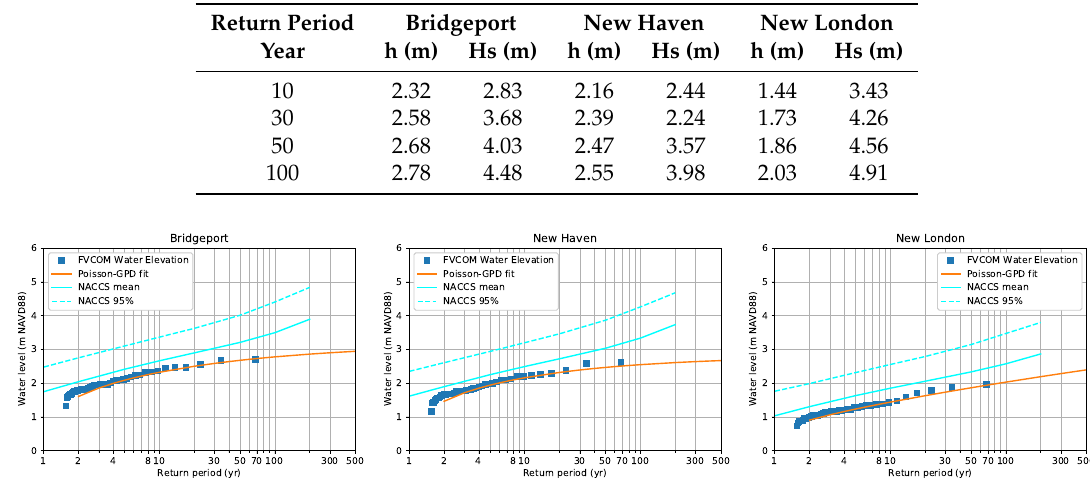
Figure 6. Estimated return level (colored contour) and return period (vertical axis) for water level ( a ) and significant wave height ( b ) evaluated at 24 locations down estuary along the Connecticut coast. The point numbers increase from west to east, 1 indicates Greenwich, whereas 24 is Stonington. Table 5. Corresponding water level (h) and significant wave height (Hs) for return periods.